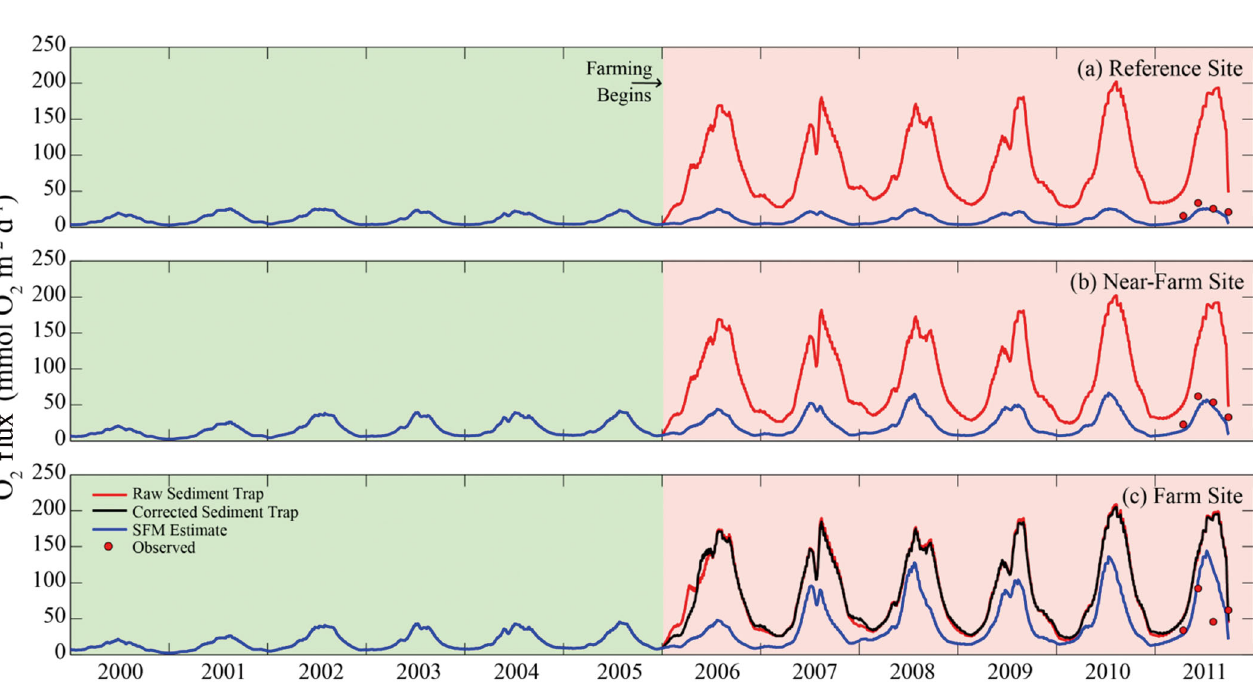
Fig. 6. Time-series (2000−2011) of modeled (lines) and observed (red circles) O 2 fluxes at (a) reference, (b) near-farm, and (c) farm sites. Green and red shading indicates pre- and post-oyster farming periods, respectively. Red line: uncorrected raw sediment trap estimates, black line: farm site sediment trap estimates corrected for resuspension, blue line: deposition esti- mated by sediment flux model (SFM) by fitting deposition to the observed sediment–water NH 4+